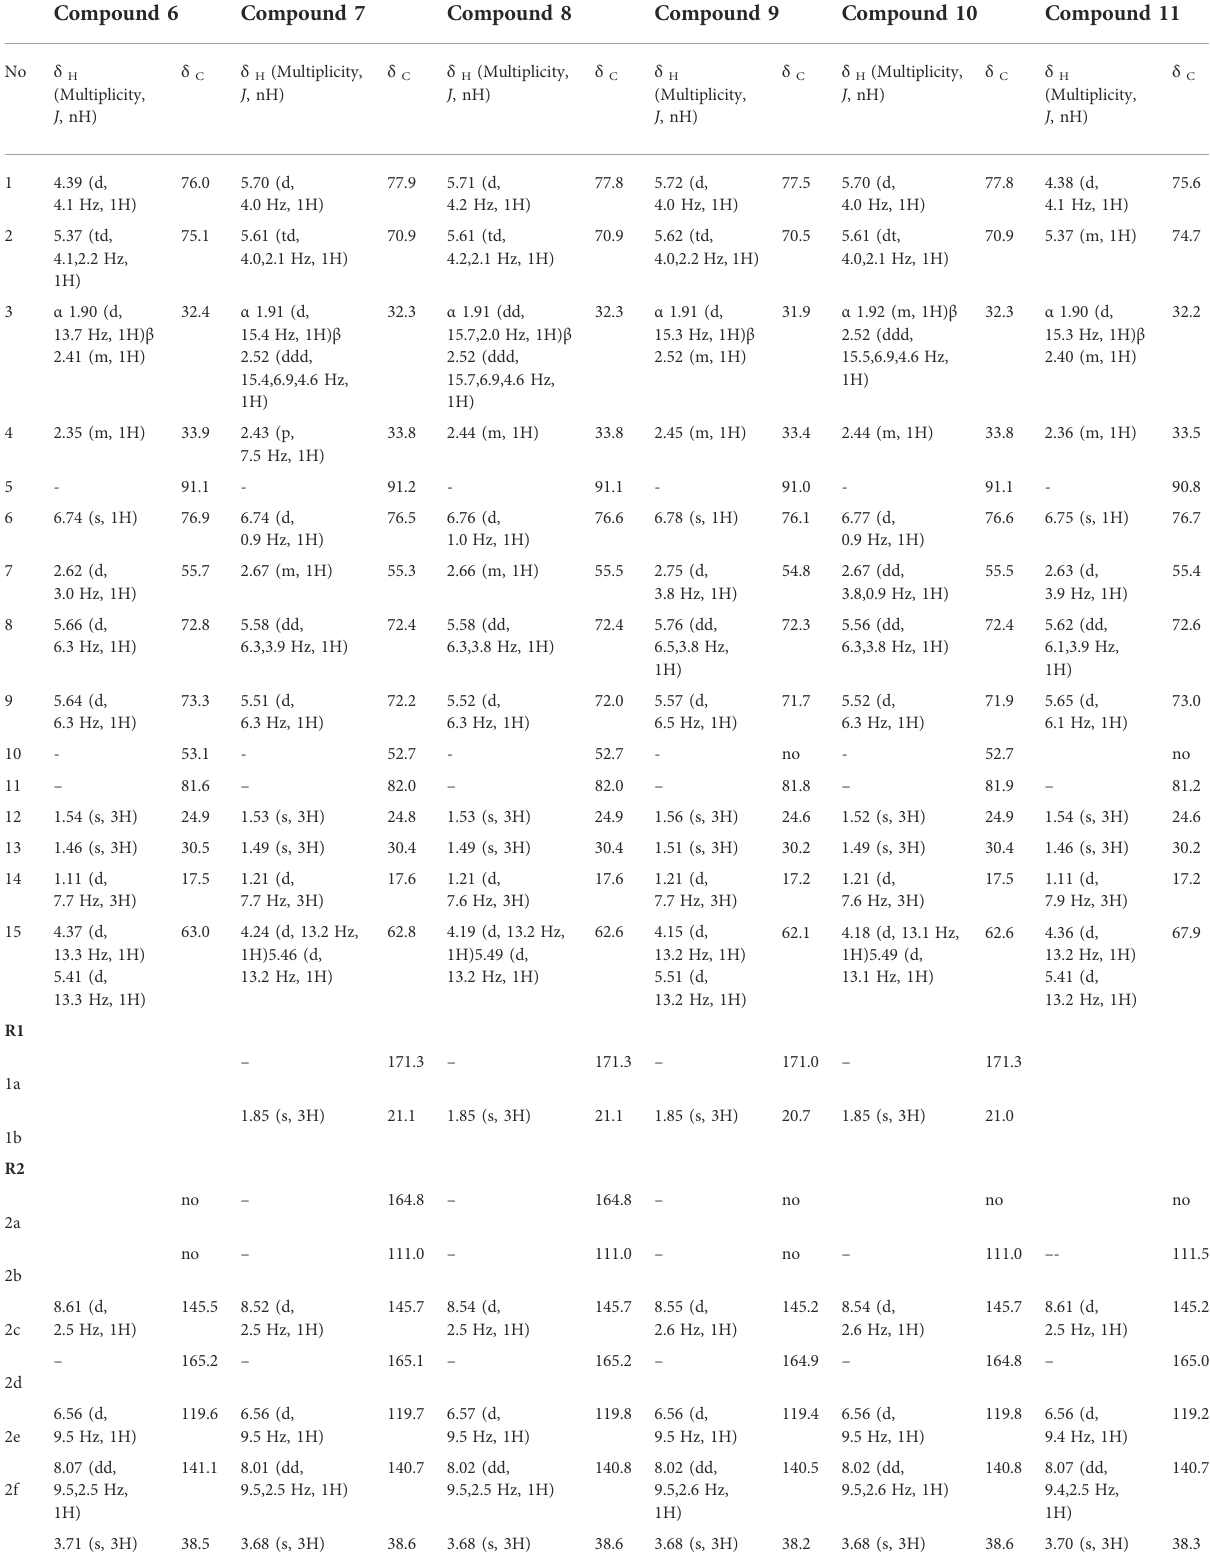
TABLE 4 1 H and 13 C NMR spectroscopic data for compounds 6 – 11 ( δ in ppm, J in